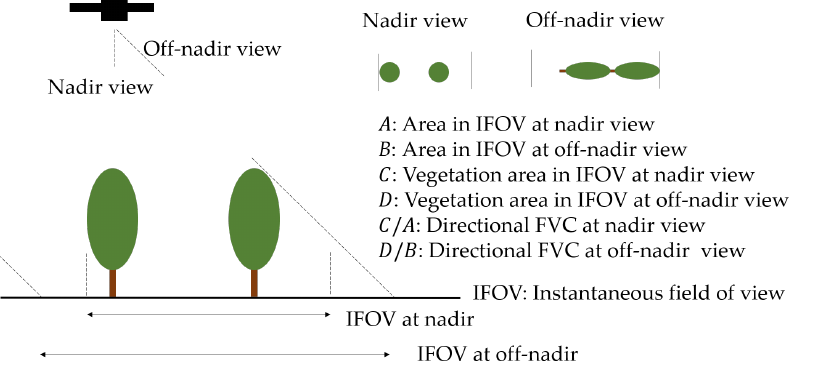
Figure 1. Illustration of the viewing angle dependency of the directional FVC. The directional FVC at nadir-view corresponds to the general definition of the